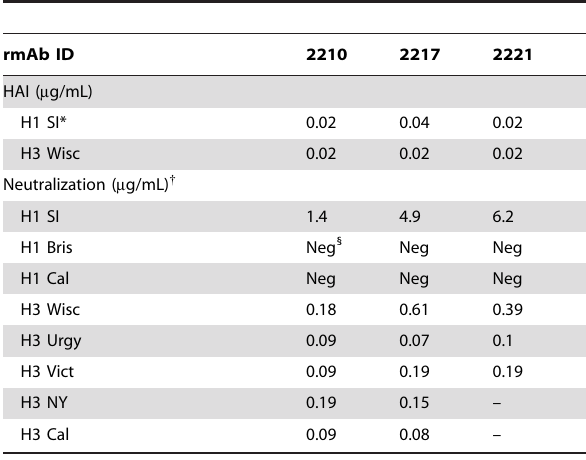
Table 3. Anti-influenza activity of rmAbs from EI13 Clonal Lineage